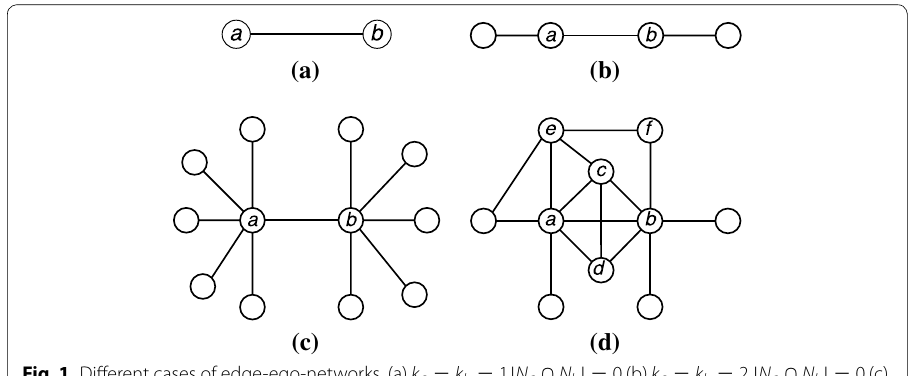
Fig. 1 Different cases of edge-ego-networks. (a) k a = k b = 1 , | N a ∩ N b | = 0 (b) k a = k b = 2 , | N a ∩ N b | = 0 (c)